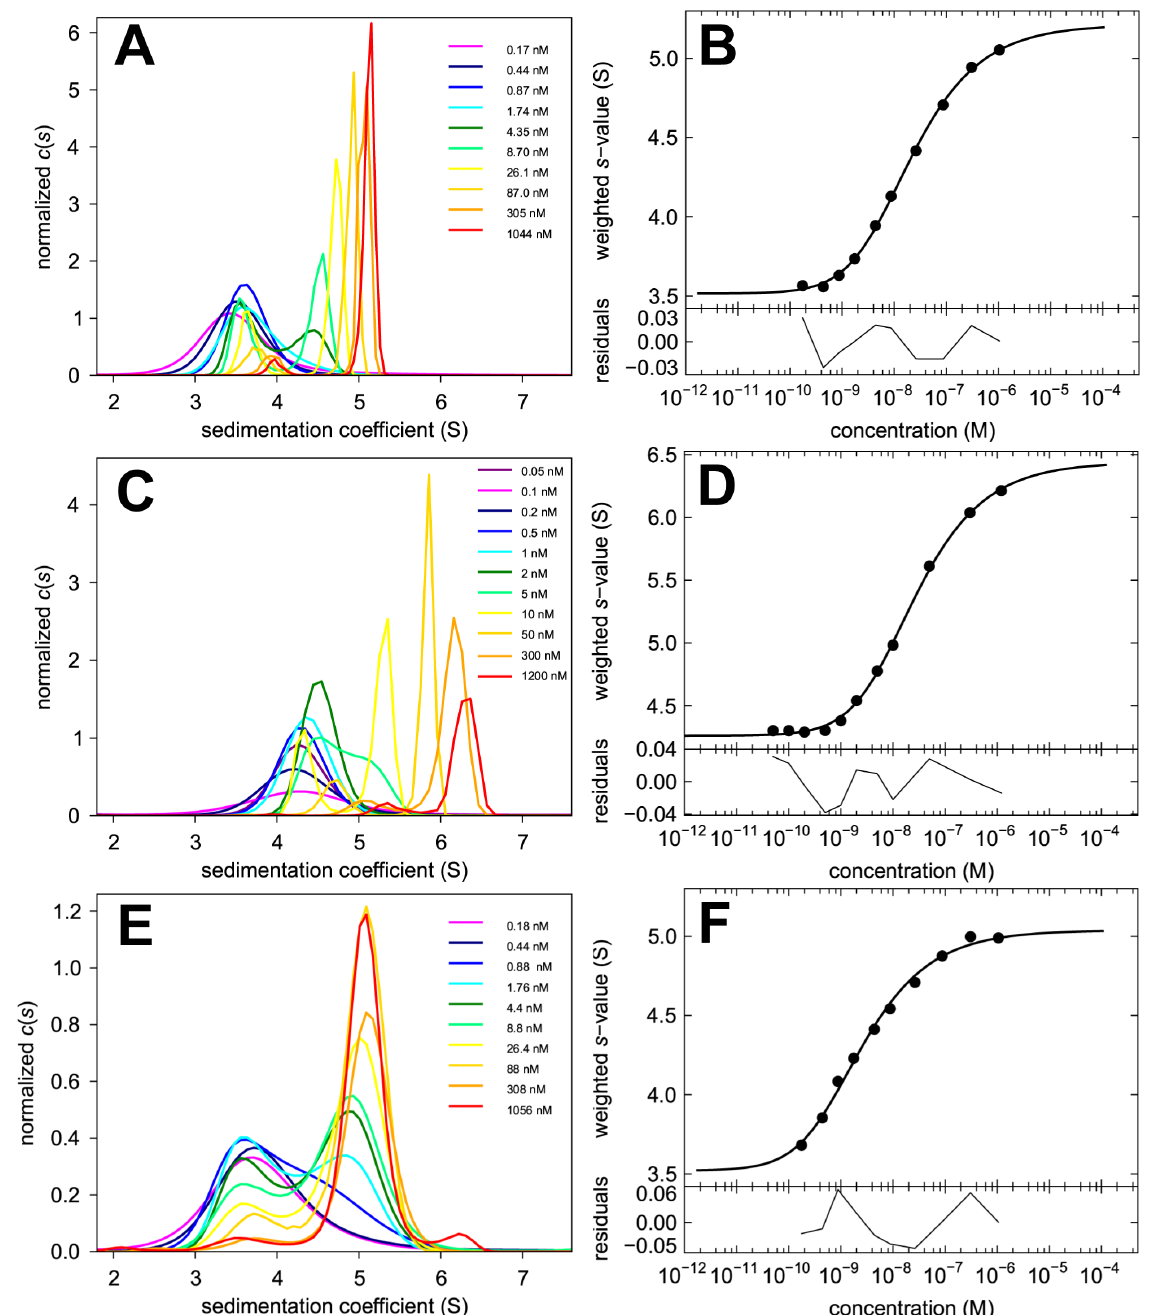
Figure 3. Dilution series with different fluorescent labels for the GluA2 ATD. Sedimentation coefficient distributions c ( s ) (Panels A, C, and E) and the resulting s w isotherms (Panels B, D, and F) from integration of c ( s ) for Dylight488-GluA2 ATD (first row), EGFP-GluA2 ATD (second row) and FAM-GluA2 ATD (third row). In the c ( s ) plots, the distributions were normalized with respect to the loading concentrations indicated. In the isotherm plots, solid circles are the s w data from the dilution series, and the solid line is the best-fit isotherm with a monomer-dimer model, resulting in best-fit estimates of K D 20.5 nM (95% CI 15.9 – 26.4), s 1 =3.52 S (95% CI 3.47 – 3.56), and s 2 =5.21 S (95% CI 5.15 – 5.28) for Dylight488-GluA2 ATD; K D =25.4 nM (95% CI 20.1 – 31.9), s 1 =4.26 S (95% CI 4.22 – 4.30), and s 2 =6.44 S (95% CI 6.35 – 6.53) for EGFP-GluA2 ATD; and K D =2.3 nM (95% CI 0.99 – 5.0), s 1 =3.52 S (95% CI 3.22 – 3.72), and s 2 =5.04 S (95% CI 4.95 – 5.14) for FAM-GluA2 ATD. doi:10.1371/journal.pone.0083439.g003 Analogous results were obtained in the dilution experiment with but due to the significantly increased molecular mass of the EGFP EGFP-GluA2 ATD ( Figure 3C and 3D ). The best-fit isotherm of fusion protein, not surprisingly, the s -values were substantially the dilution data led to a K D estimate of 25.4 nM (95% CI 20.1 – higher. Again, the fitted monomer and dimer s -values were very well defined with s 1 = 4.26 S (95% CI 4.22 – 4.30), and s 2 = 6.44 S 31.9), which is consistent with the Dylight488-GluA2 ATD result,